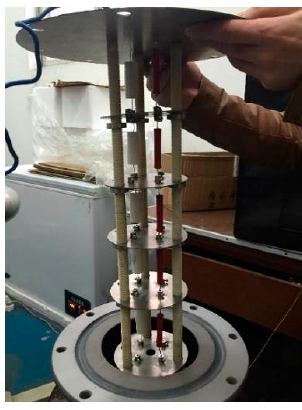
Figure 16. Capacitive divider of low-voltage CVT model.